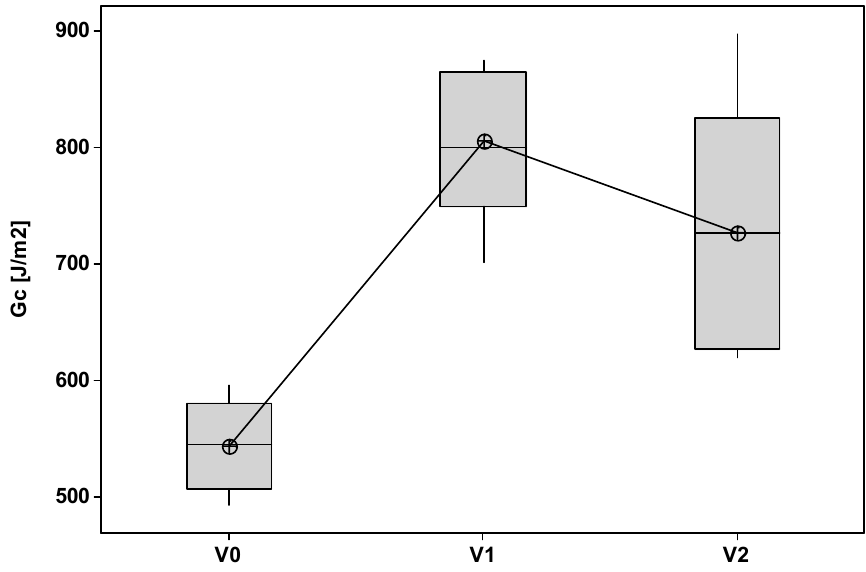
Figure 10. G IC values for the laminates modified with soluble veils.